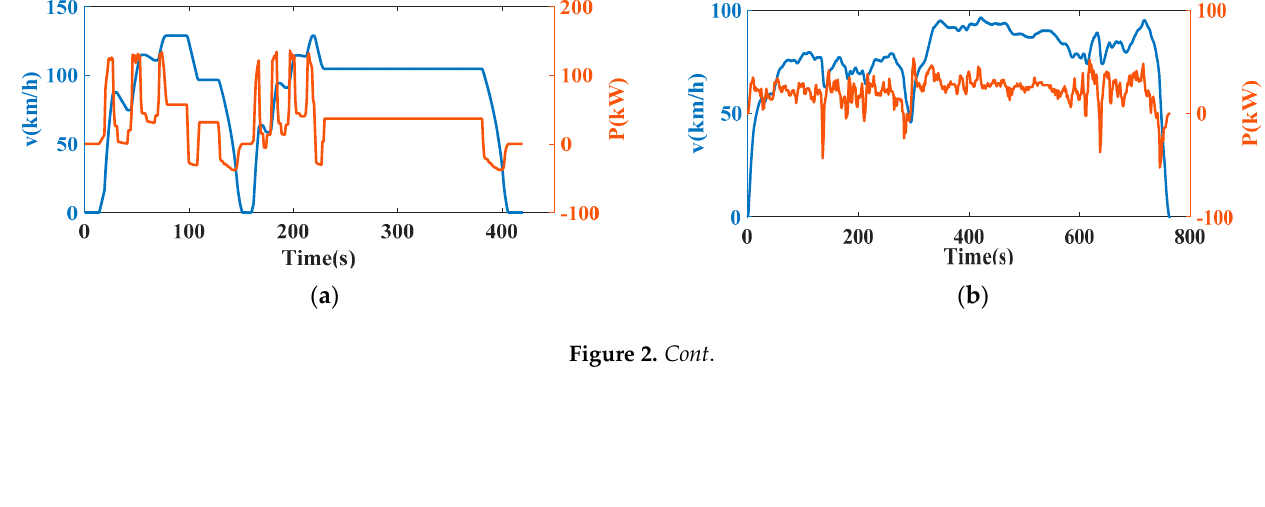
Table 1. Parameters and performance indicators of the EV.